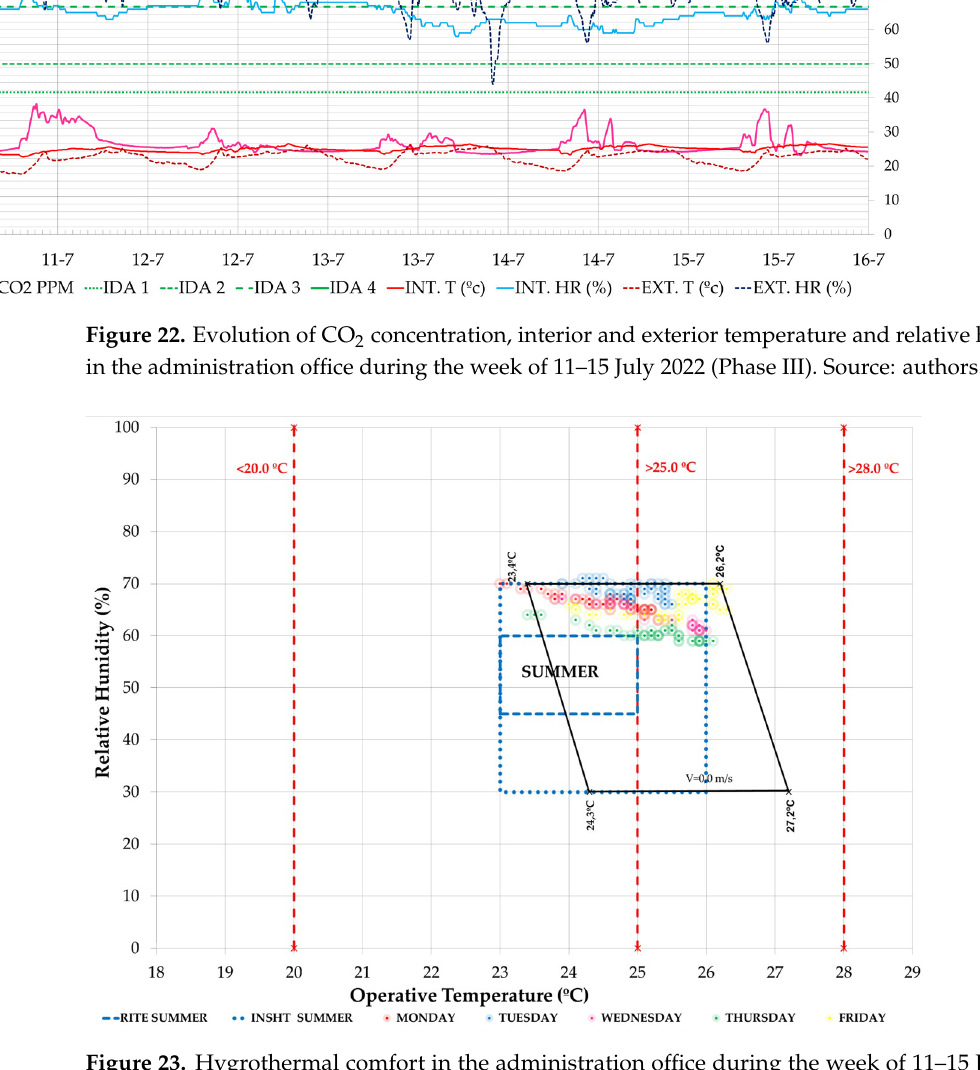
Figure 23. Hygrothermal comfort in the administration office during the week of 2022-07-11 to 2022- 07-15 (Phase III). Source: authors.